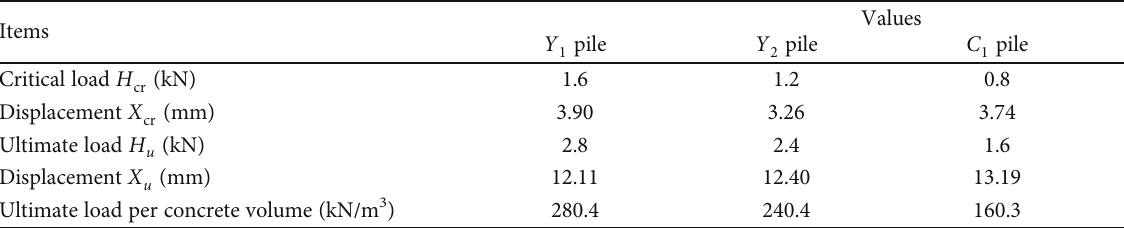
Table 7: Results of horizontal model tests.